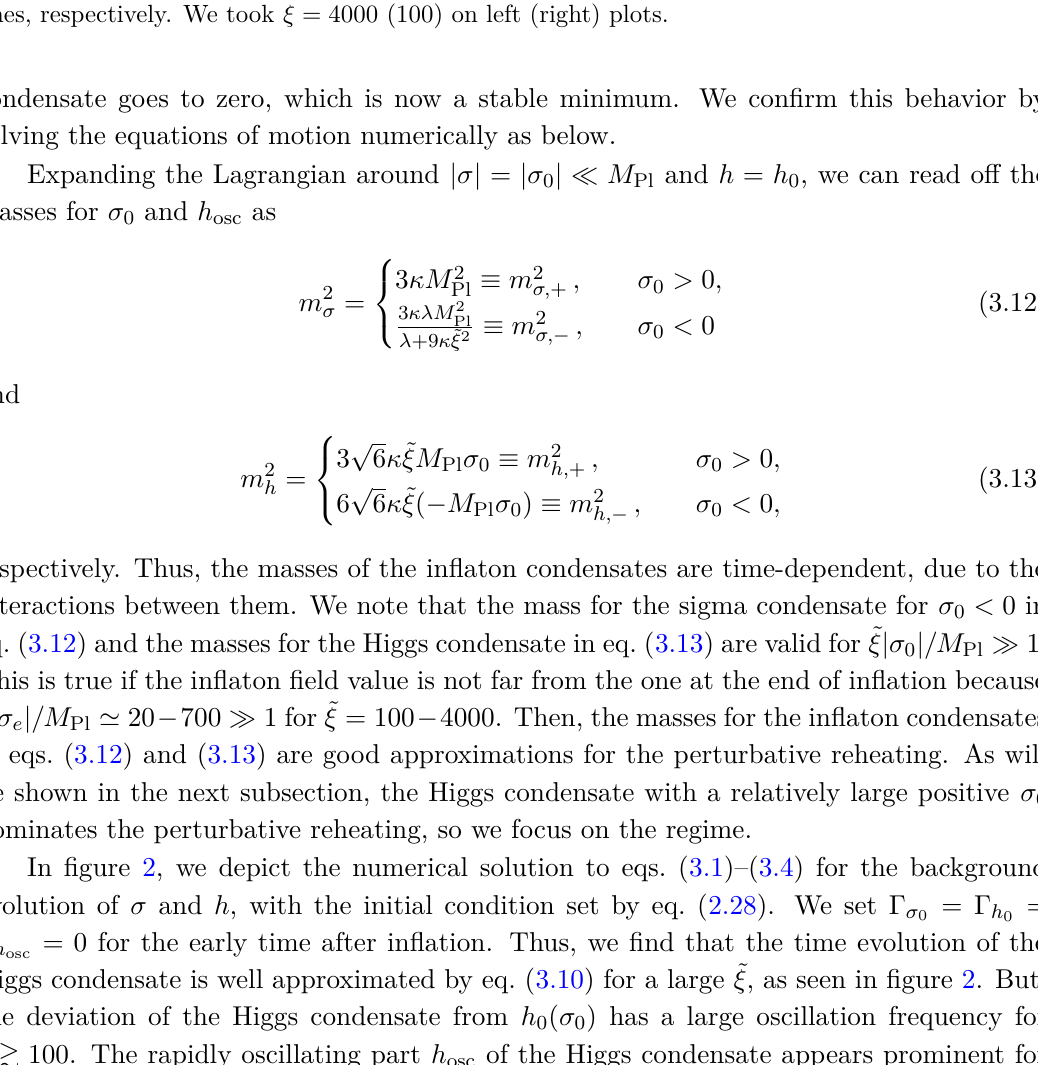
Figure 2 . Time evolution of inflaton condensates, σ and h , during reheating, in red and black lines, respectively. We took ξ = 4000 ( 100 ) on left (right)